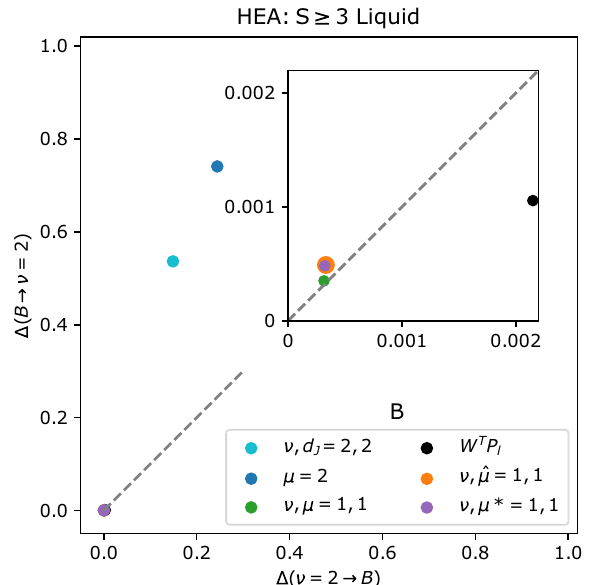
Fig. 6 Information imbalance plane for HEA liquid. Information imbalance plane for the environments from liquid con fi gurations with S ≥ 3 in the HEA dataset. Note the difference in scale relative to the amino